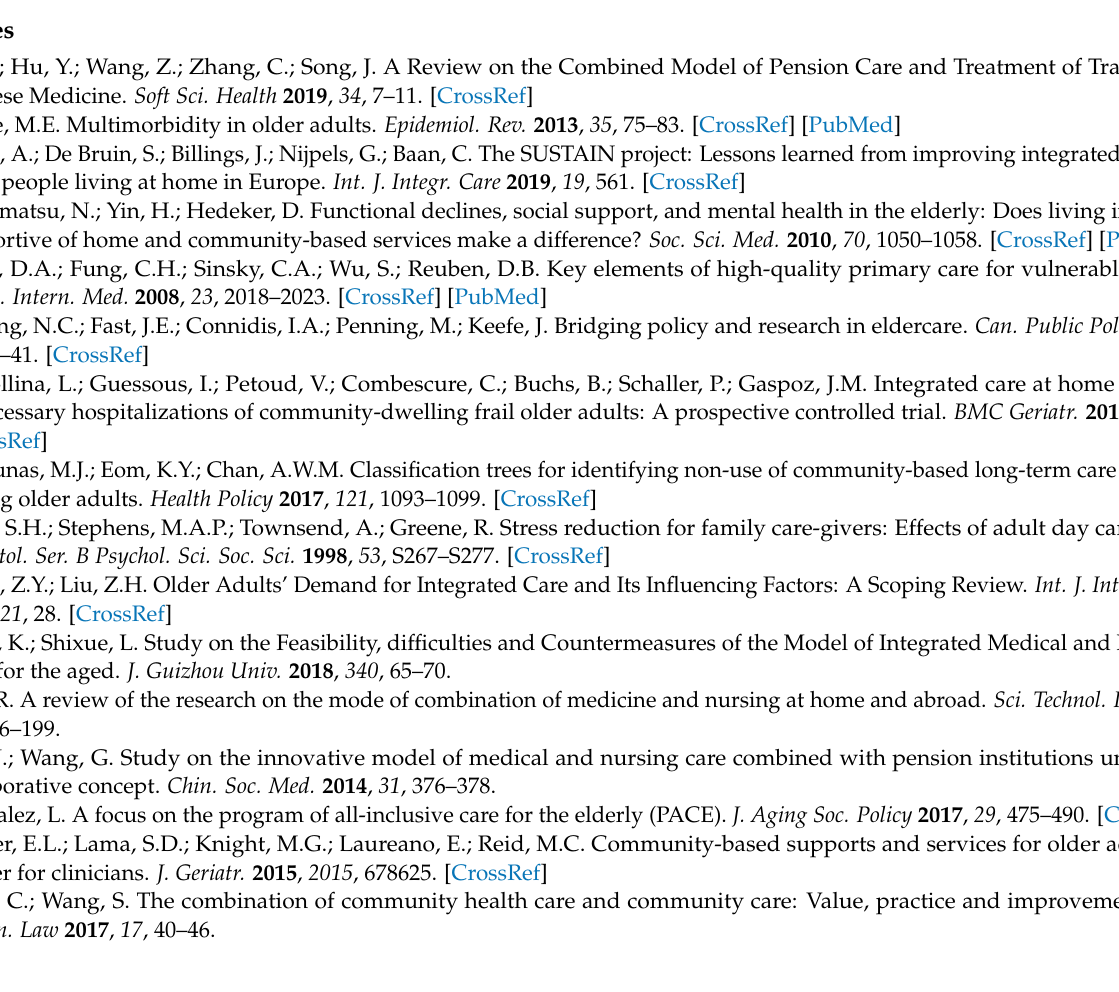
Figure A3. Theoretical model of the factors influencing the demand for CBAS integrated with medical care.